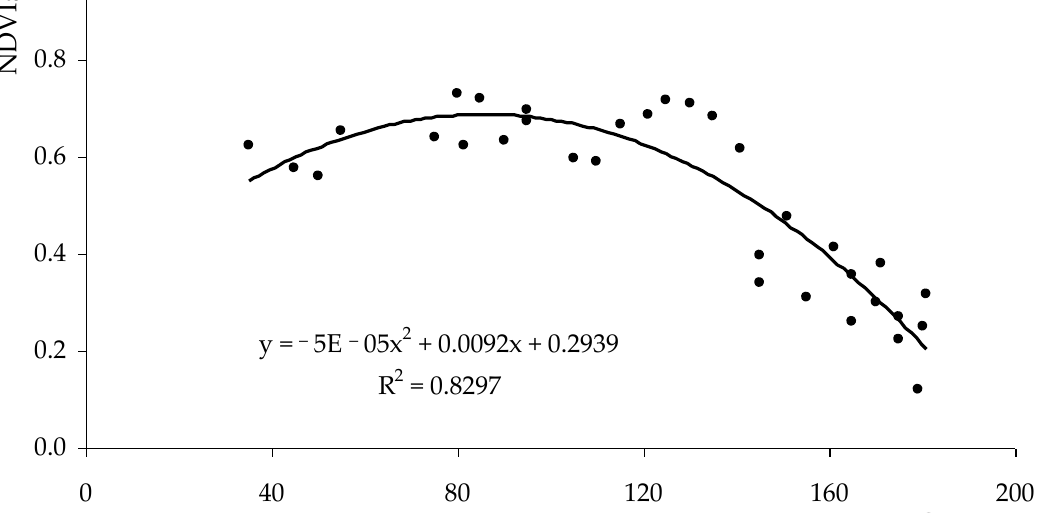
Figure 8. Trend line of vegetation index obtained by satellite (NDVI SAT ) between February and June over three years (2016 – 2018). Data are average values of the twelve sampling points. DOY-Day of the year.